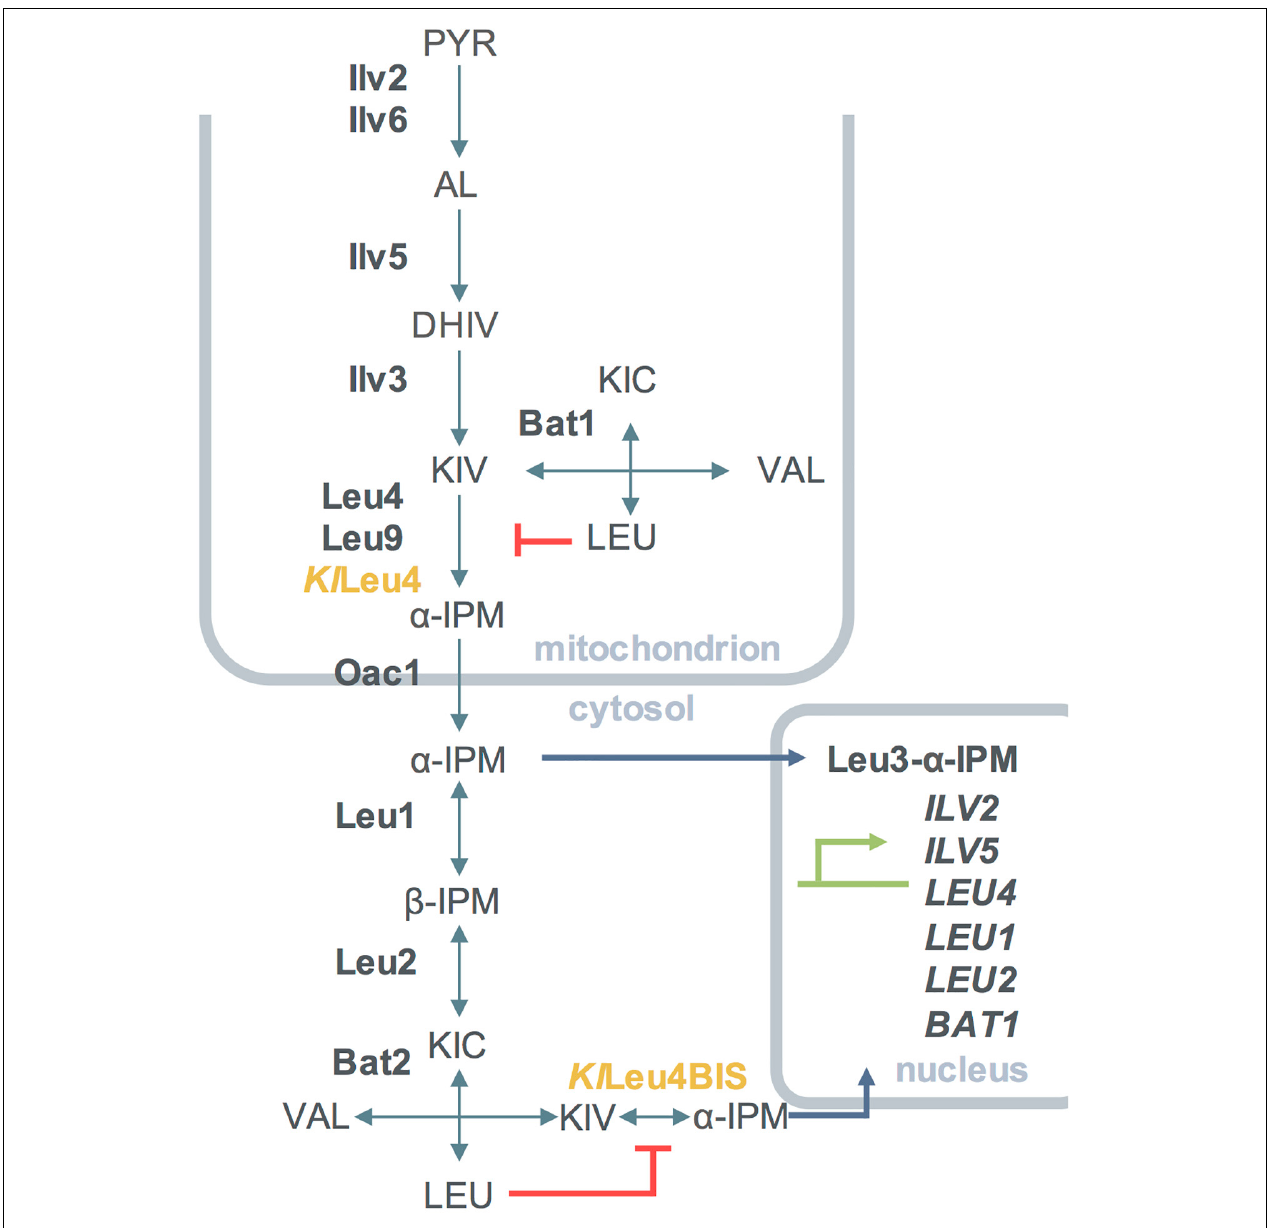
FIGURE 1 | Diagrammatic representation of the compartmentalization of the leucine amino acid biosynthetic pathway of S. cerevisiae including K. lactis α -IPMSs when transformed in S. cerevisiae . Simple and double arrows indicate reactions considered to be irreversible and reversible, respectively. Enzymes from K. lactis are shown in yellow, enzymes form S. cerevisiae are shown in bold font, metabolites are shown in capital letters, genes activated by Leu3- α -IPM are shown in capital italic letters. Enzymes involved in the pathway are as follows: Ilv2, acetohydroxy acid synthase catalytic subunit; Ilv5, acetohydroxy acid reductoisomerase; Ilv3, dihydroxy acid dehydratase; Bat1, mitochondrial branched-chain amino acid aminotransferase; Bat2, cytosolic branched-chain amino acid aminotransferase; Leu4, α -isopropylmalate synthase, Leu9, α -isopropylmalate synthase; Leu1, isopropylmalate isomerase; Leu2, β -isopropylmalate dehydrogenase, Kl Leu4, α -isopropylmalate synthase, Kl Leu4BIS, α -isopropylmalate synthase. PYR, pyruvate; AL, acetolactate; DHIV, dihydroxyisovalerate; KIV, ketoisovalerate; α -IPM, α -isopropylmalate; β -IPM, β -isopropylmalate; KIC- α , ketoisocaproate; aCoA, Acetyl coenzyme